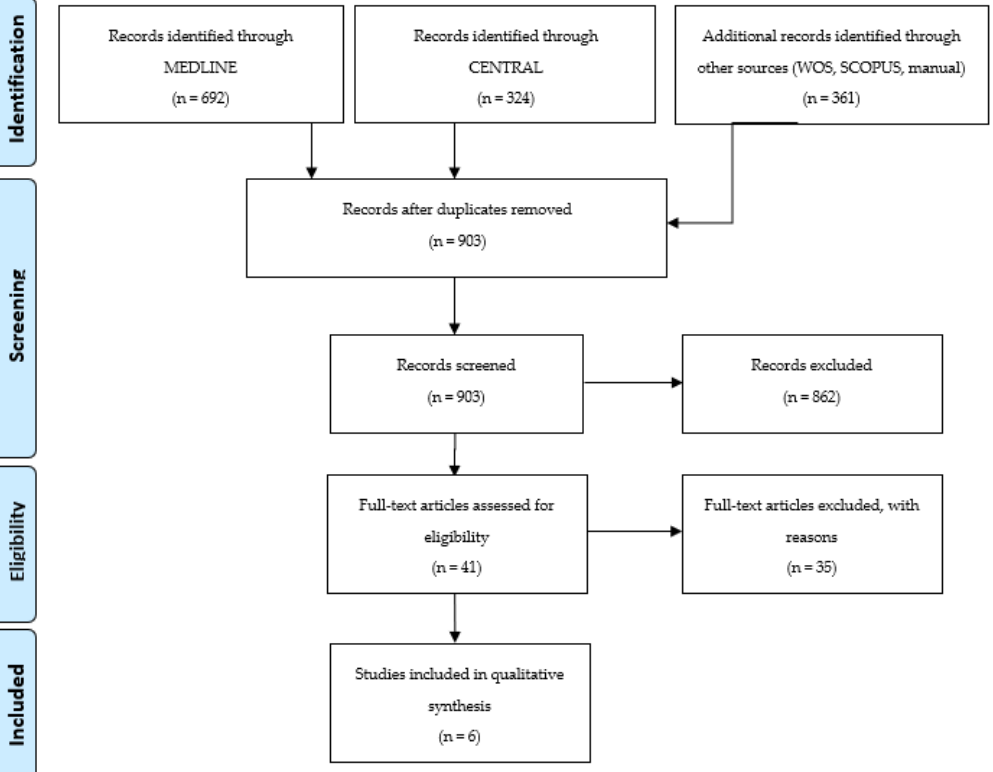
Figure 1. Prisma Flow Diagram.